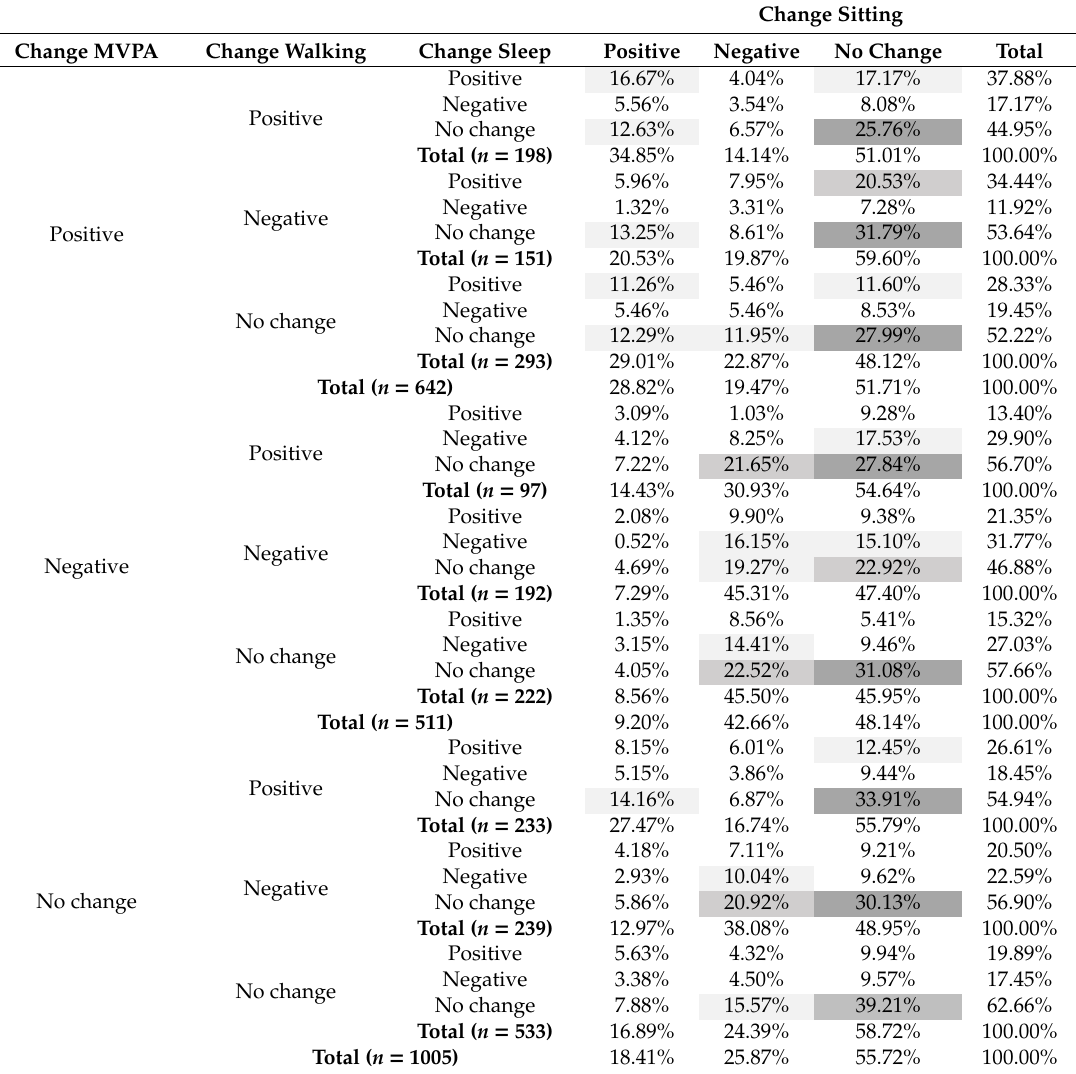
Table 4. Cross-behavioral change from T1 to T2 ( n =